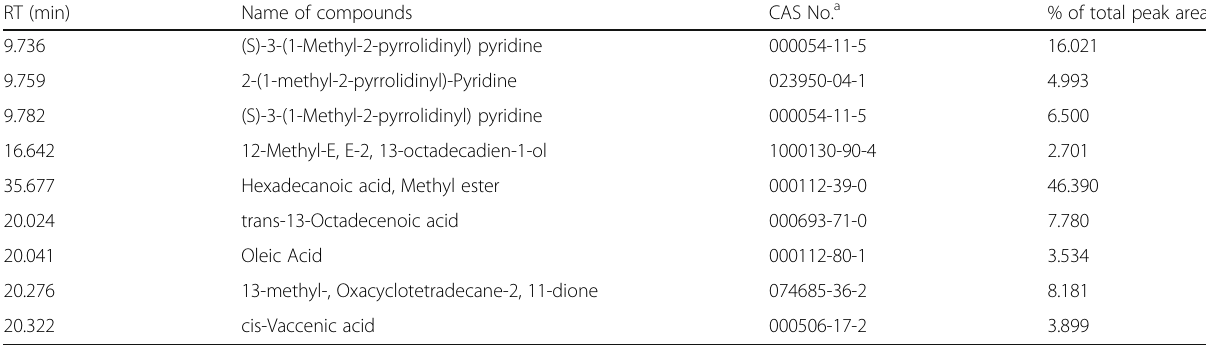
Table 3 Compounds identified in mixture of Azadirachta indica plus Nicotiana